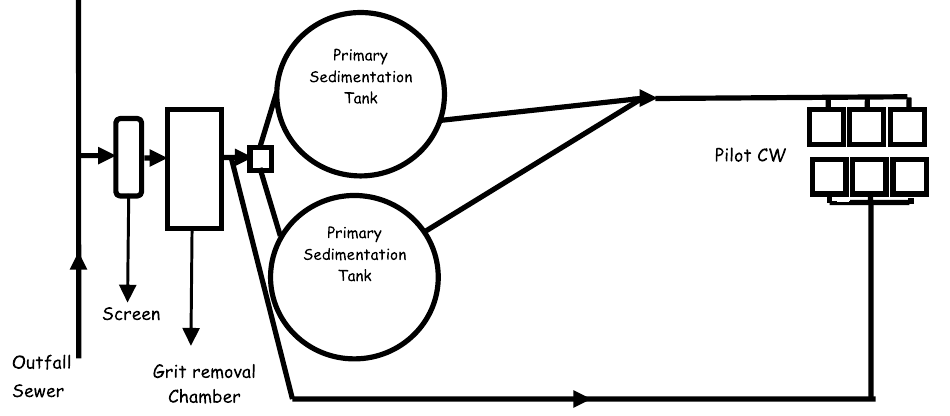
Fig. 2 Schematic diagram of flow from the Outfall sewer to